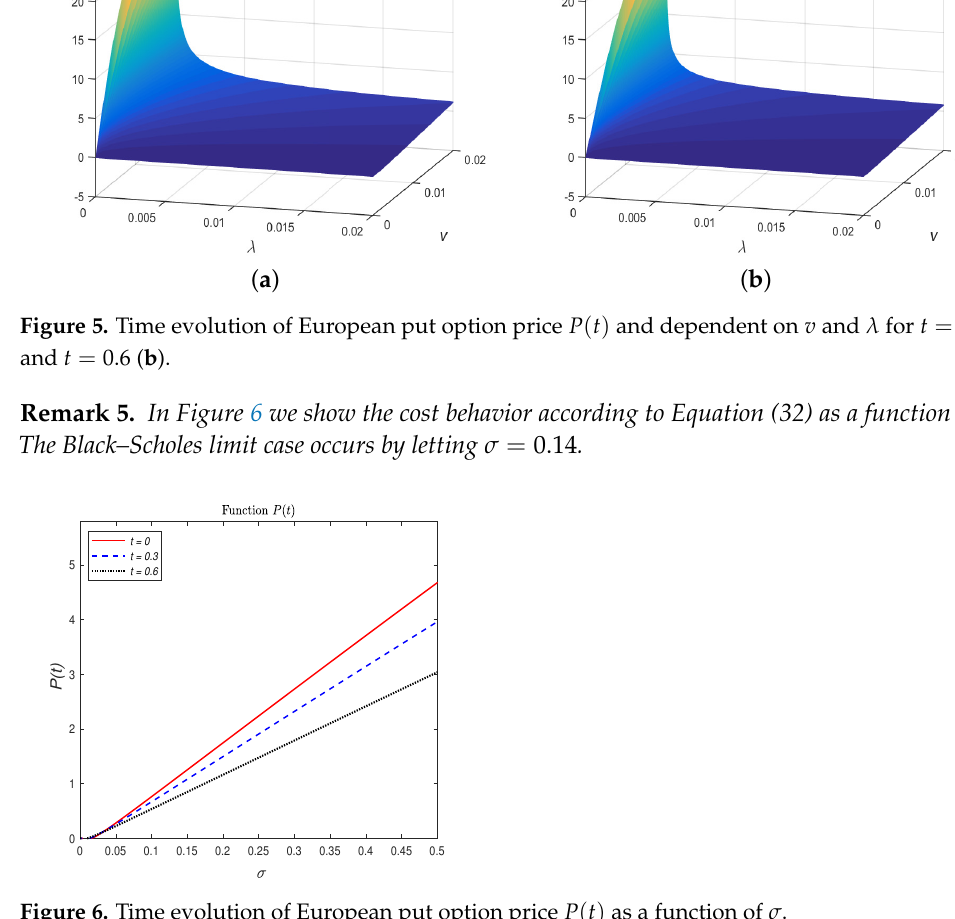
Figure 6. Time evolution of European put option price P ( t ) as a function of σ